Question: Briefly state, in one sentence, what is plotted here.
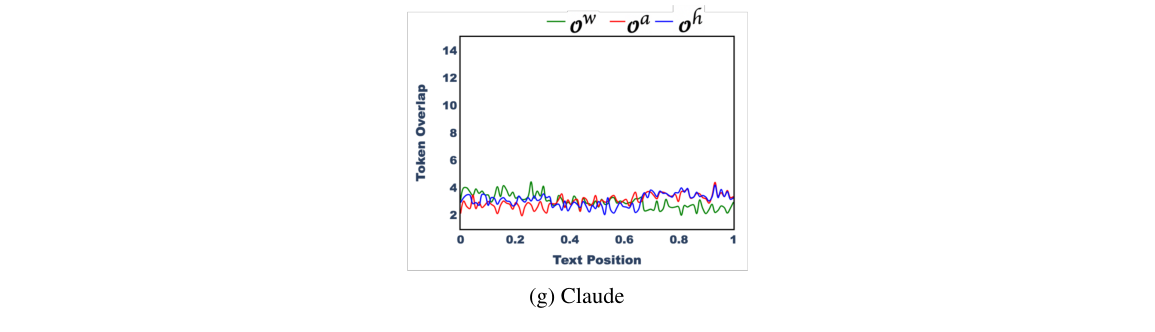
Answer: Average token overlap between ordered system-generated summaries by each of the seven abstractive summarization models and each document di in the input set D of the DivSumm dataset. Text position on the x-axis has been normalized between 0 and 1.